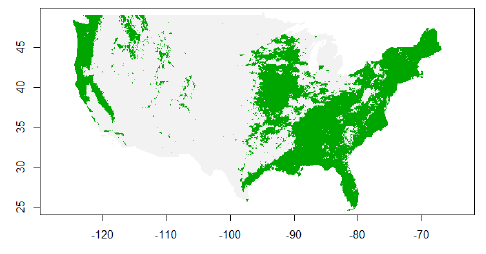
Figure 2. High Precipitation Area of US mainland in